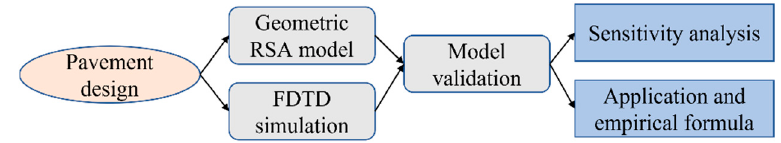
Figure 1. Flowchart of proposed